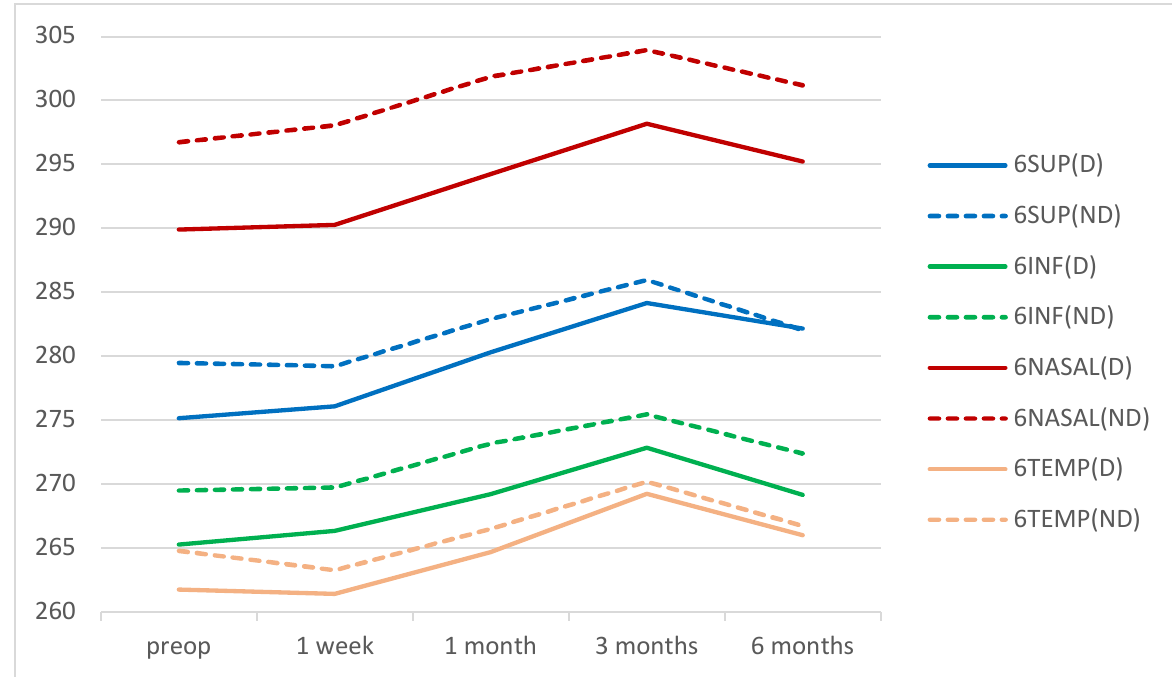
Figure 3. Mean values of the retinal thicknesses in the 3 mm ring of the ETDRS macular grid for DM patients and non-diabetic subjects during the follow-up time points. Values are expressed in microns.